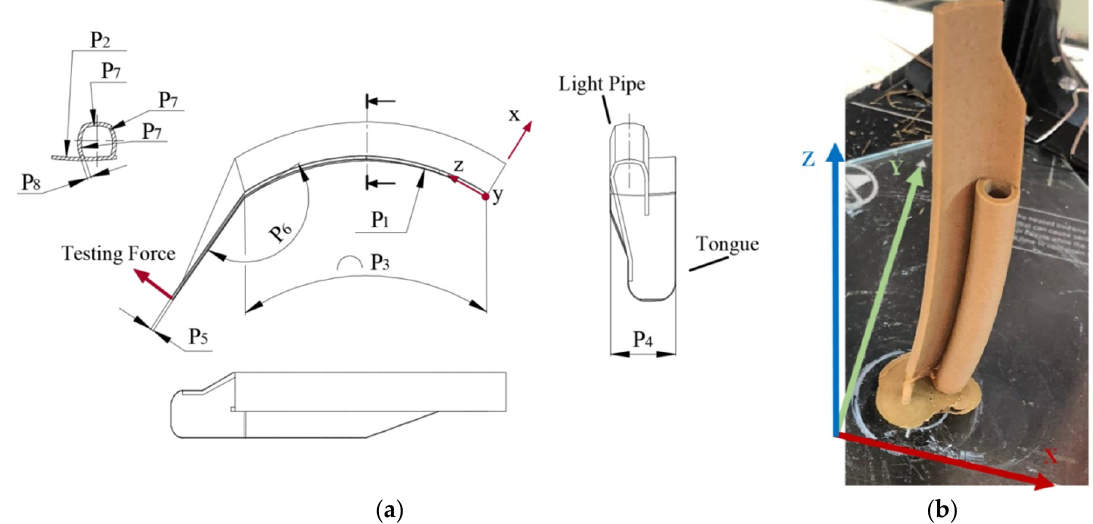
Figure 7. ( a ) Geometric blade parametrization. ( b ) Laryngoscope manufactured with Hemp filament.